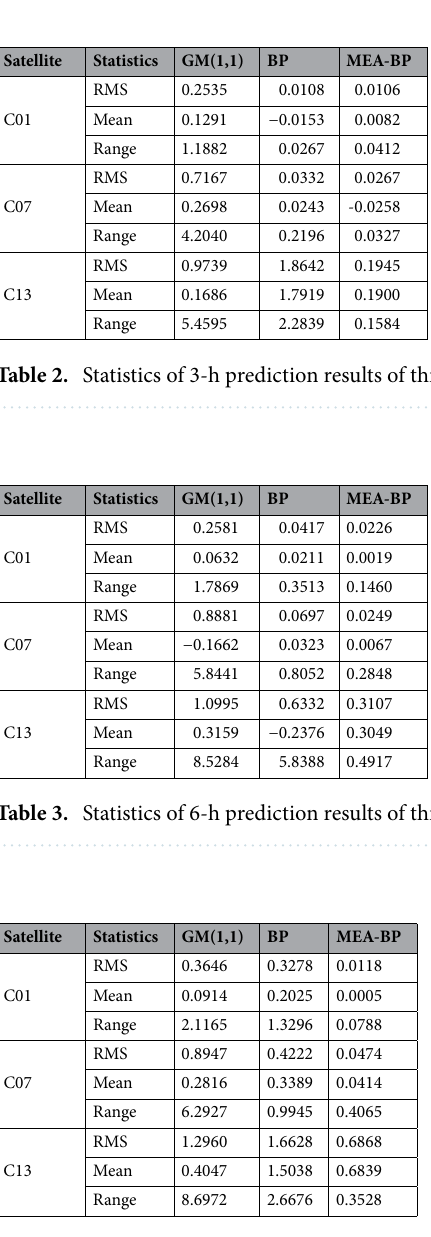
Table 4. Statistics of 12-h prediction results of three satellites (unit: